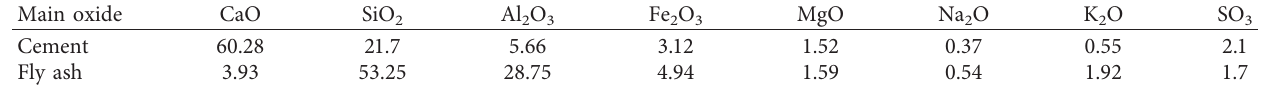
Table 1: Chemical contents of cement/fly ash based on XRF analysis (% by mass).